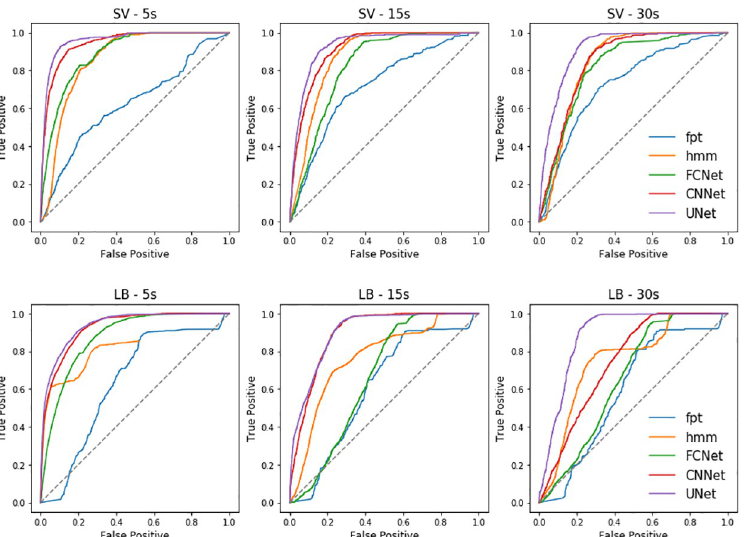
Fig 3. Performance of deep networks on pescadores dataset. ROC curves obtained from the prediction of 5 algorithms, First-Time Passage (FPT), Hidden Markov Models (HMM), Fully-Connected Network (FCNet), Fully- Convolutional Network (CNNet) and U-Network (UNet) on 2 distinct test datasets resampled at 3 different resolutions (5, 15 and 30s) derived from two seabirds species breeding in Pescadores Island from 2008 to 2013. SV stands for Peruvian boobies ( Sula variegata ), and LB stands for Guanay cormorants ( Leucocarbo bougainvilli ).